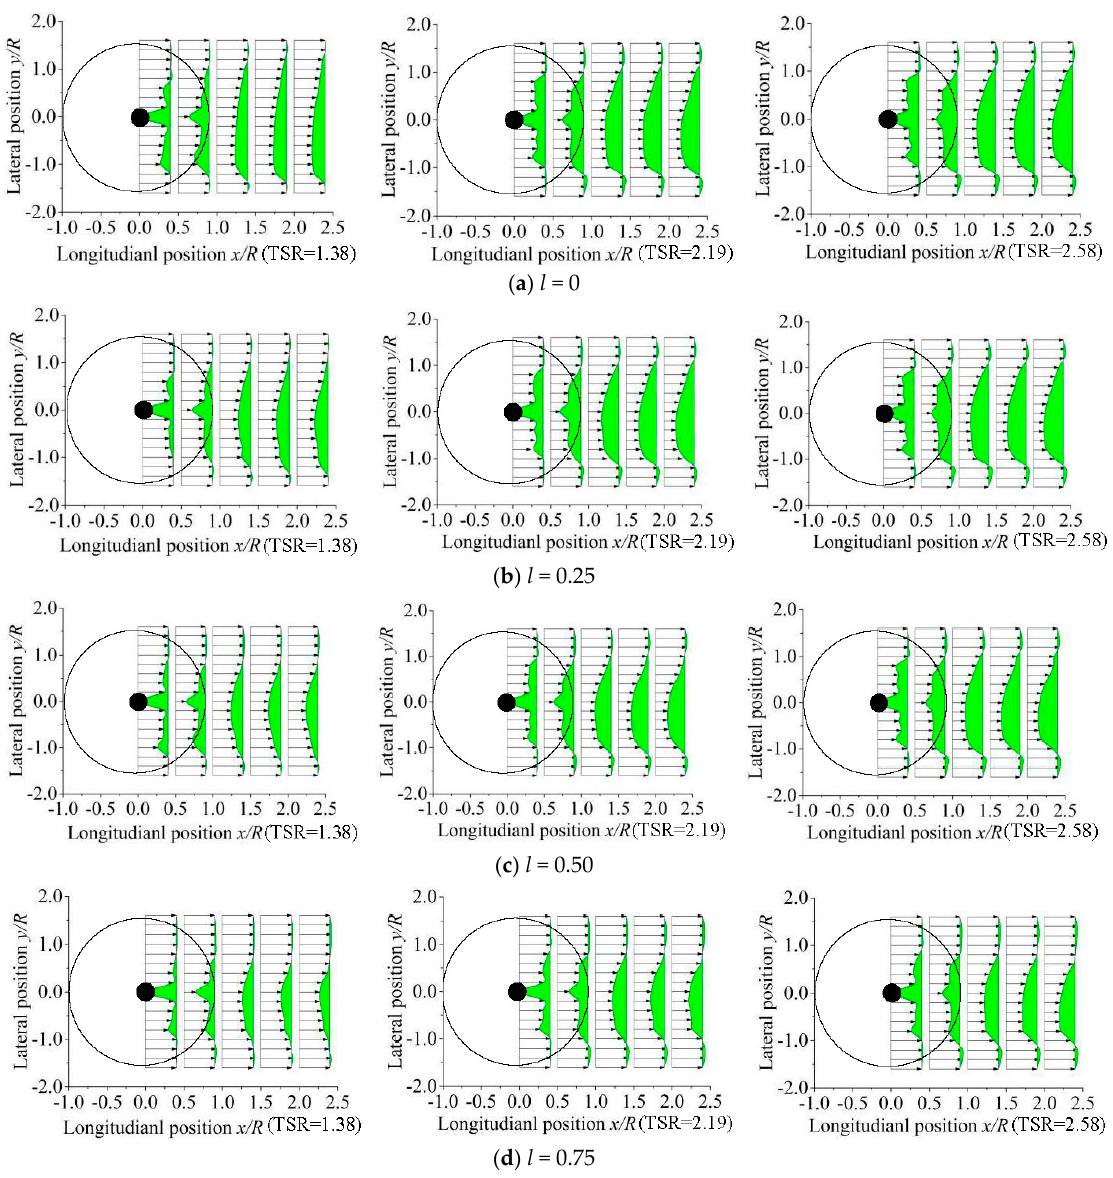
Figure 12. Comparison of wind velocity deficit between the different spanwise cross-sections of l = 0, 0.25, 0.50 and 0.75 for the downstream region( x/R = 0, 0.5, 1.0, 1.5 and 2.0) at the three different TSRs: ( a – d ) show the wind velocity deficits of l =0, 0.25, 0.5 and 0.75, respectively.